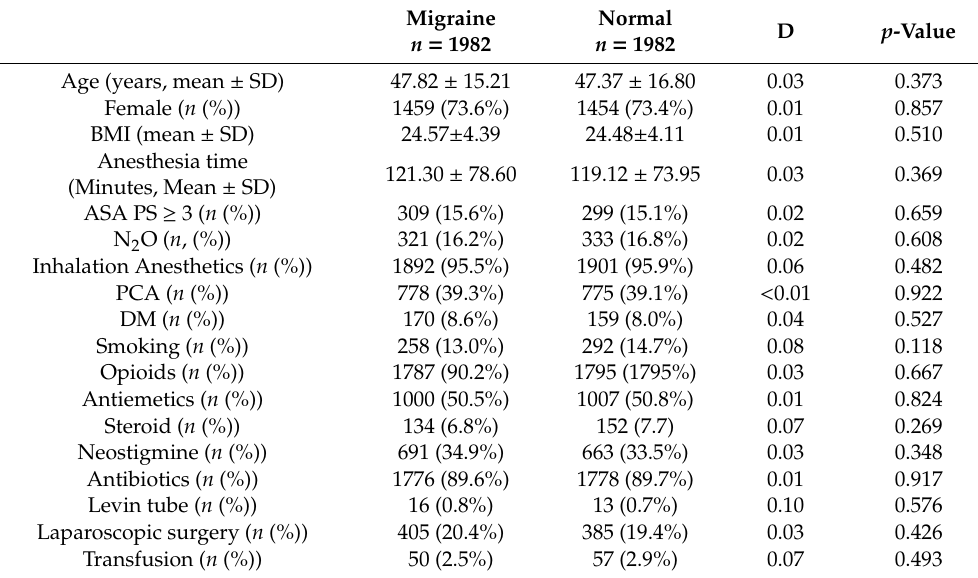
Table 2. Characteristics of the two groups after propensity score matching.